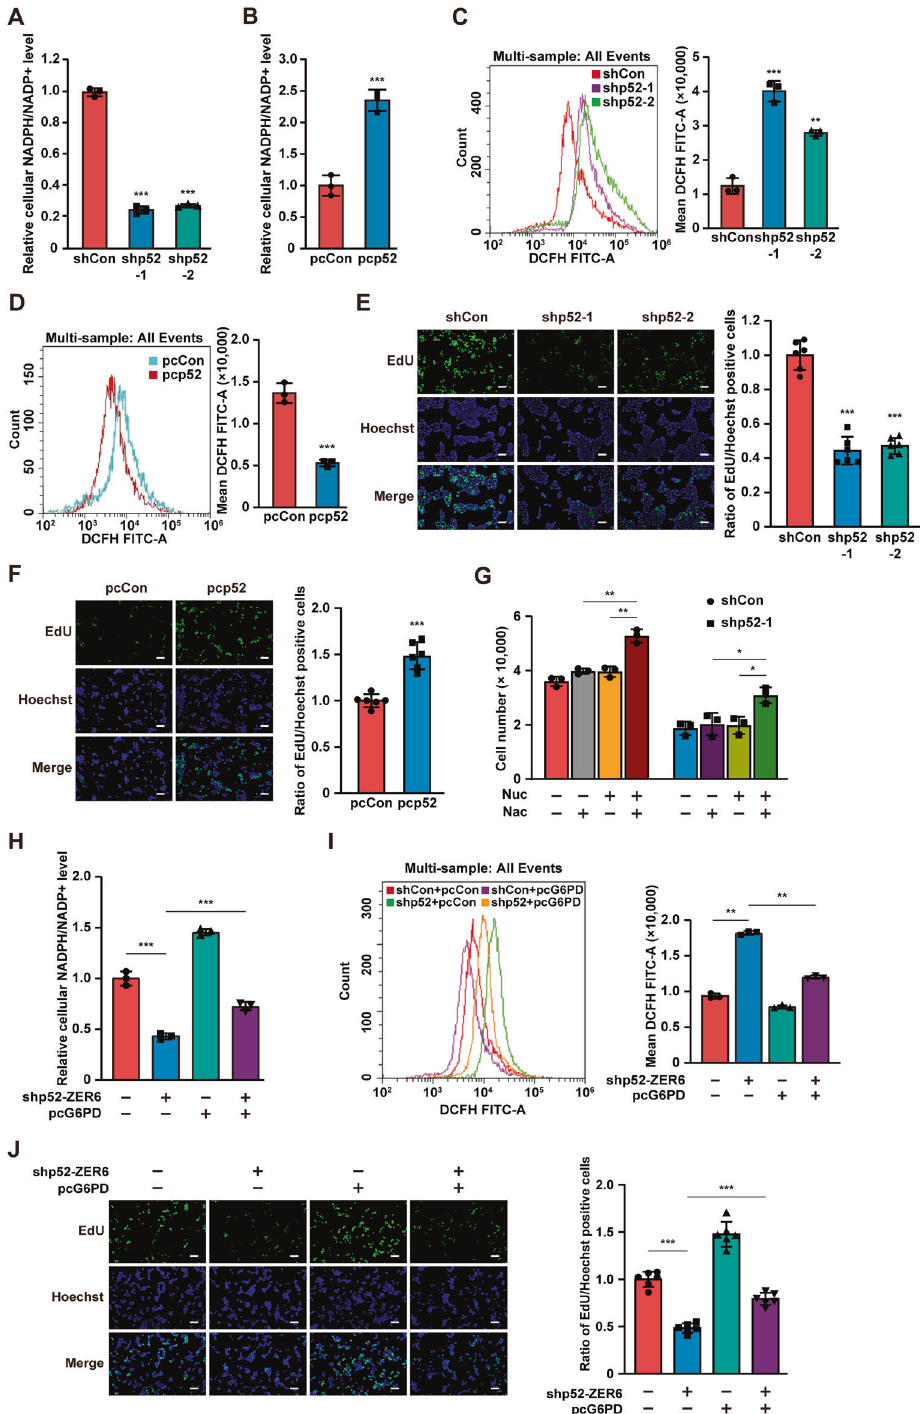
Fig. 3 G6PD is crucial for p52-ZER6 regulation on PPP. A , B Intracellular NADPH/NADP + ratio in p52-ZER6 -silenced ( A ) and p52-ZER6 - overexpressed ( B ) HCT116 cells. C , D Intracellular ROS levels in p52-ZER6 -silenced ( C ) and p52-ZER6 -overexpressed ( D ) HCT116 cells. E , F DNA replication in p52-ZER6 -silenced ( E ) and p52-ZER6 -overexpressed ( F ) HCT116 cells, as determined using EdU incorporation assay. Representative images (left; scale bars: 50 μ m) and quantitative results (right; n = 6) are shown. G Viability of p52-ZER6 -silenced HCT116 cells cultured in the presence of nucleosides mixture (Nuc) and/or ROS scavenger (N-acetyl-L-cysteine, Nac), as measured at the third day after the addition of nucleosides mixture and/or ROS scavenger. H , I Intracellular NADPH/NADP + ratio ( H ) and ROS level ( I ) in p52-ZER6 -silenced, G6PD -overexpressed HCT116 cells. J DNA replication in p52-ZER6 -silenced, G6PD -overexpressed HCT116 cells, as determined using EdU incorporation assay. Representative images (left, scale bars: 50 μ m) and quantitative results (right, n = 6) are shown. Cells transfected with shCon and/or pcCon were used as controls. Quanti fi cation data are expressed as mean ± SD ( n = 3, unless otherwise indicated). shp52: shRNA expression vector targeting p52-ZER6 ; pcCon: pcEF9-Puro; pcp52: p52-ZER6 overexpression vector; * P < 0.05; ** P < 0.01; *** P < 0.001.